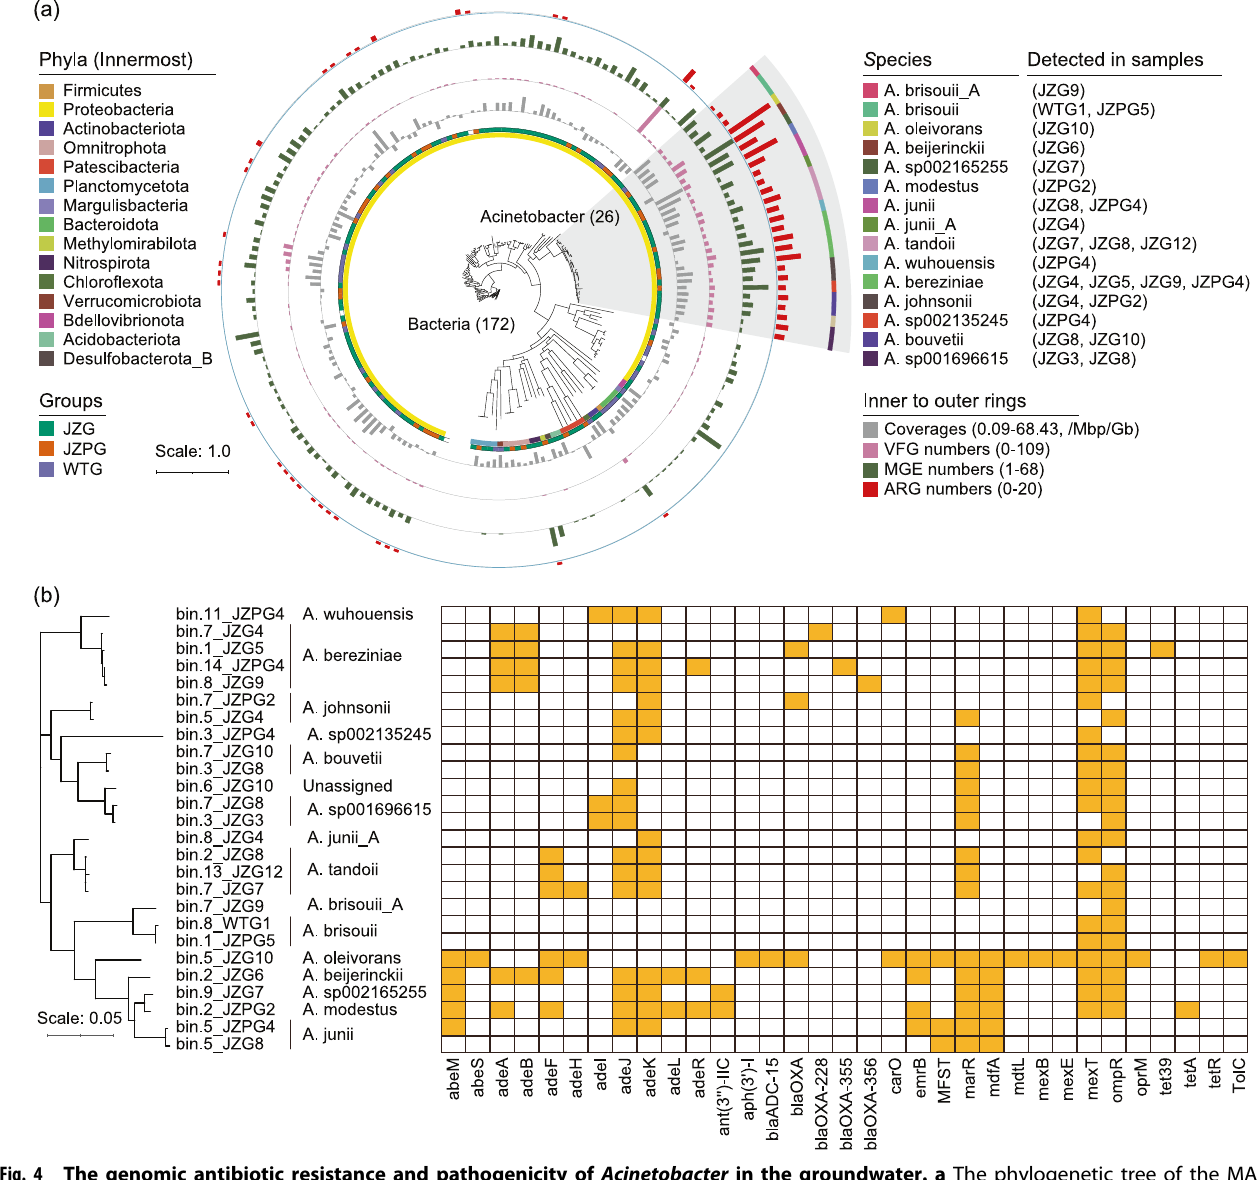
Fig. 4 The genomic antibiotic resistance and pathogenicity of Acinetobacter in the groundwater. a The phylogenetic tree of the MAGs. Values in brackets are genome numbers of bacteria and Acinetobacter . Acinetobacter genomes are highlighted in the shadow. Rings represent phylum, group, genomic coverage as well as numbers of VFGs, MGEs and ARGs from the innermost to the outermost. b ARG compositions in Acinetobacter genomes. ARG antibiotic resistance gene, VFG virulence factor gene, MGE mobile gene element, JZG residential groundwater in the swine farming village, JZPG swine farm groundwater in the swine farming village, and WTG residential groundwater in the reference